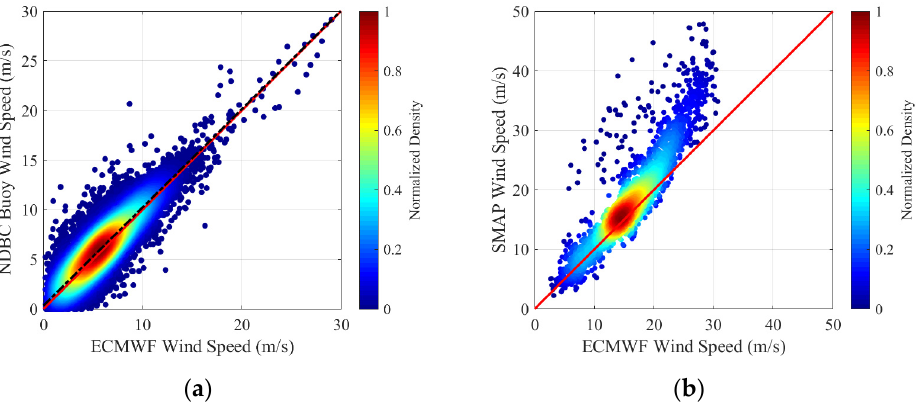
Figure 2. Comparison of ECMWF wind speed with ( a ) the in situ measurements of NDBC buoy data (NO. 41047), ( b ) the measurements of the SMAP radiometers.